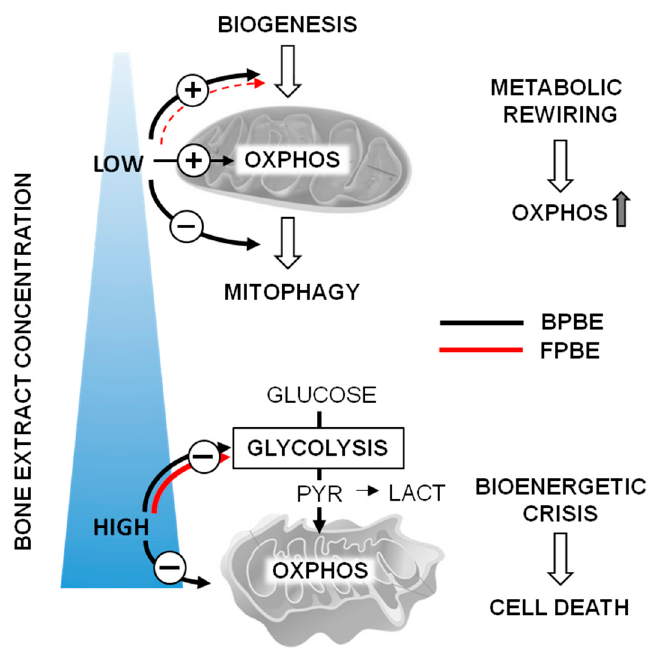
Figure 7. Schematic drawing of the major e ff ects of chicken bone extracts on mitochondrial function described in this study; the circled “ + ” an “ − “ indicate stimulation and inhibition, respectively, of the indicated function with the thickness of the line proportional to the intensity of the e ff ect. OXPHOS, oxidative phosphorylation; PYR, pyruvate; LACT, lactate. See Discussion for further